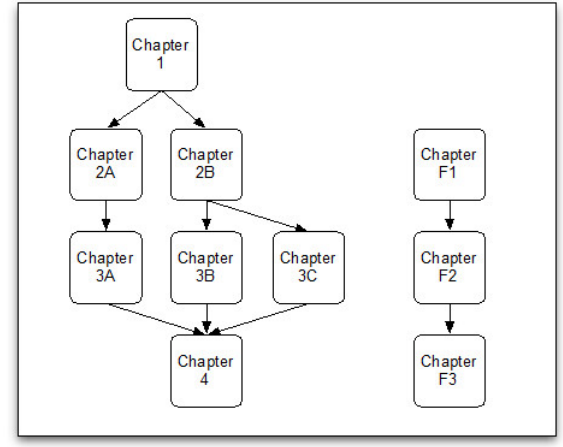
Figure 1. Example of in-book